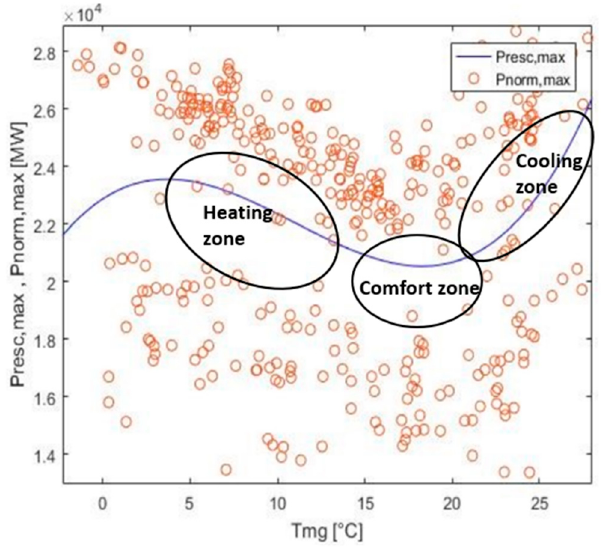
Figure 2. Temperature dependency of consumed energy. Each dot is a combination of consumption and daily average temperature for one day; the curve is the interpolating line [34].